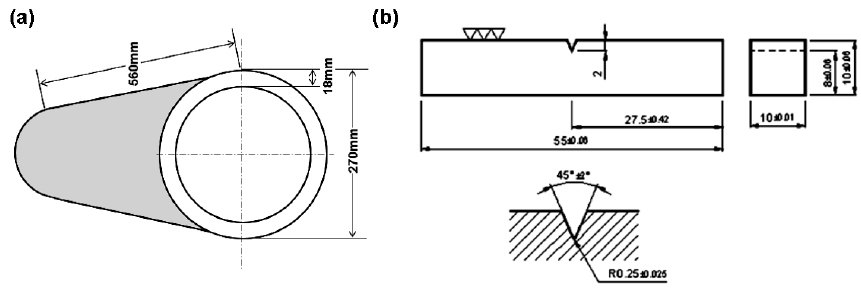
Figure 1. Schematic of pipe size and charpy V-notch impact specimen ( a ) pipe size ( b ) single-notch.